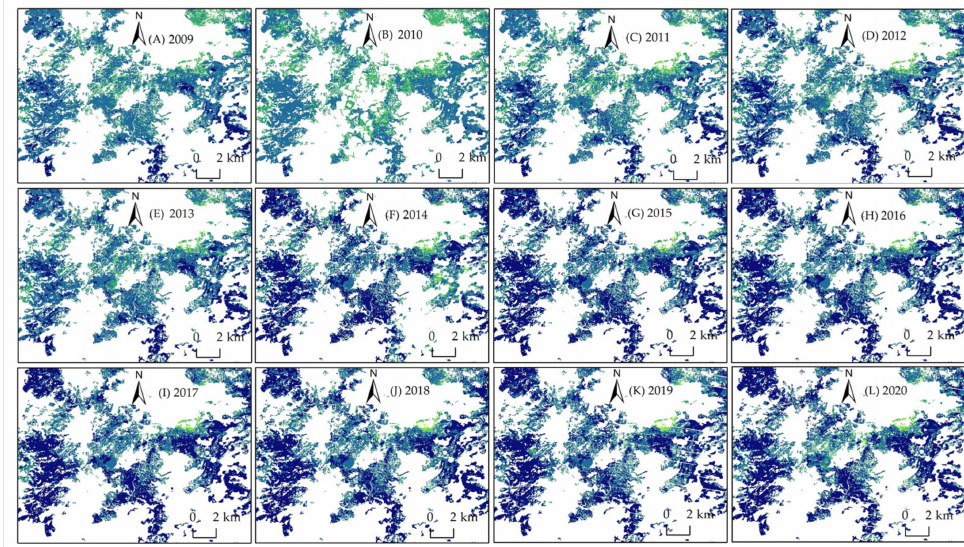
Figure 8. Pine forest coverage from 2009 to 2020, the darker the color, the higher the coverage level.